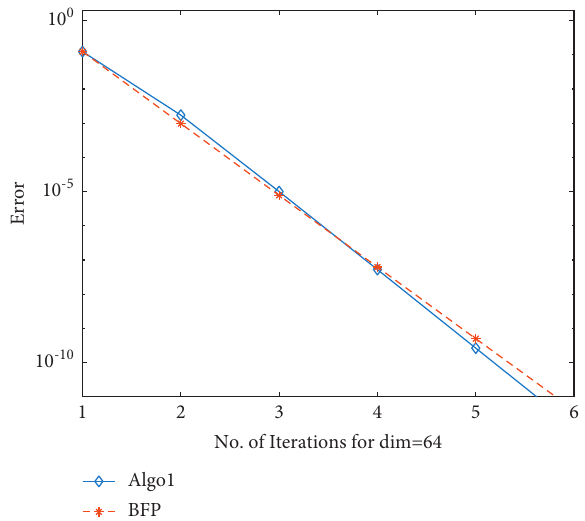
Figure 24: Iteration no. vs error for dimension 64.